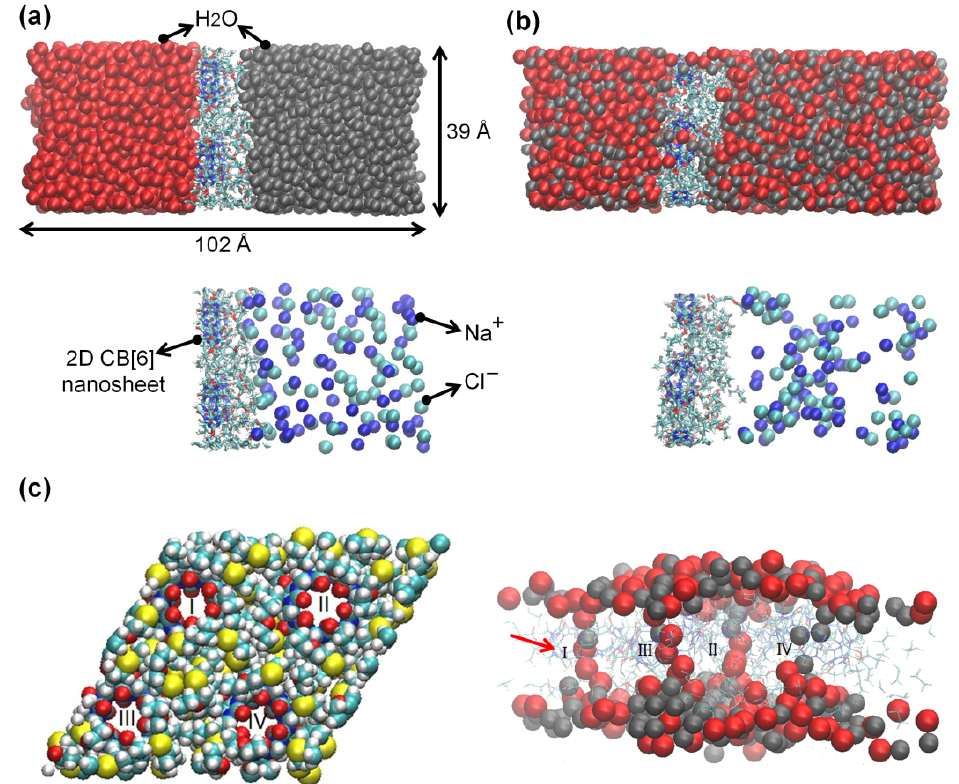
Figure 3. Simulation system consists of the 2D CB[6] nanosheet, pure water (red sphere, left), and a 2.37 M NaCl solution (gray sphere, right) at ( a ) 0 and ( b ) 100 ns. Water molecules and NaCl ions of salt water are presented separately for clarity. ( c ) Top view of the 2D CB[6] nanosheet (left) and side view of the simulation system including water molecules within 5 Å away from the 2D CB[6] nanosheet at 100 ns